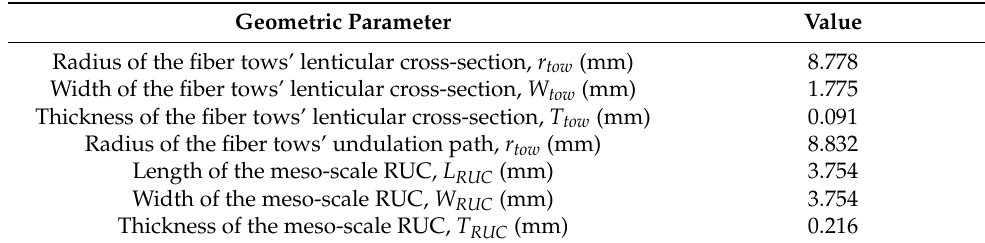
Figure 9. Geometric parameters in establishing the meso-scale RUC. Table 7. Geometric parameters of the meso-scale RUC from T300/Cycom970 fabrics.